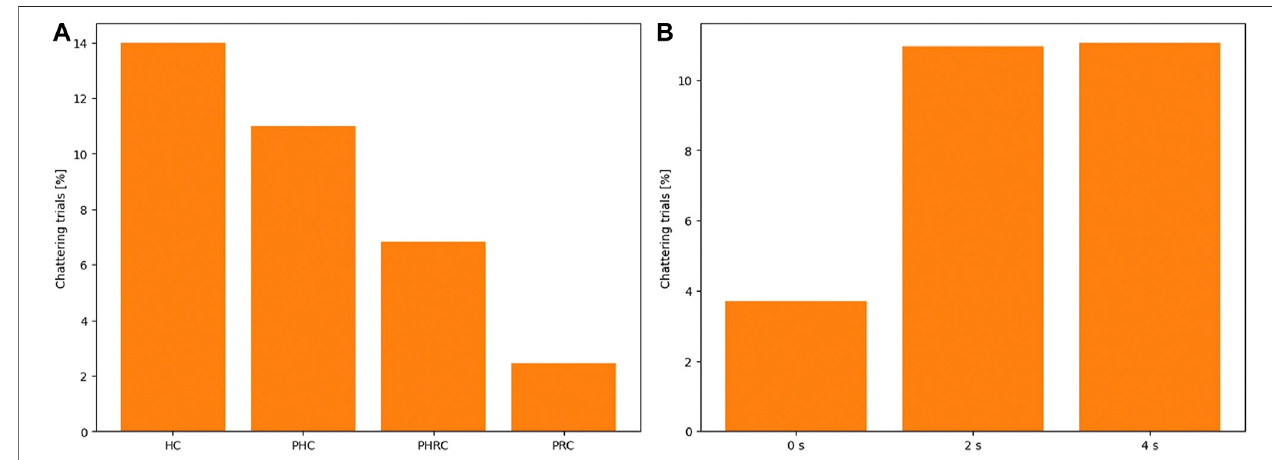
FIGURE7| Totalpercentagesofchatteringtrialsamongallsubjectsandallconditions,foratotalof600trials,asafunctionofthedifferentmodality (A) andthedelay condition (B) . Chattering is de fi ned as the detachment of the sensor from the dummy ’ s surface after initial contact is made.